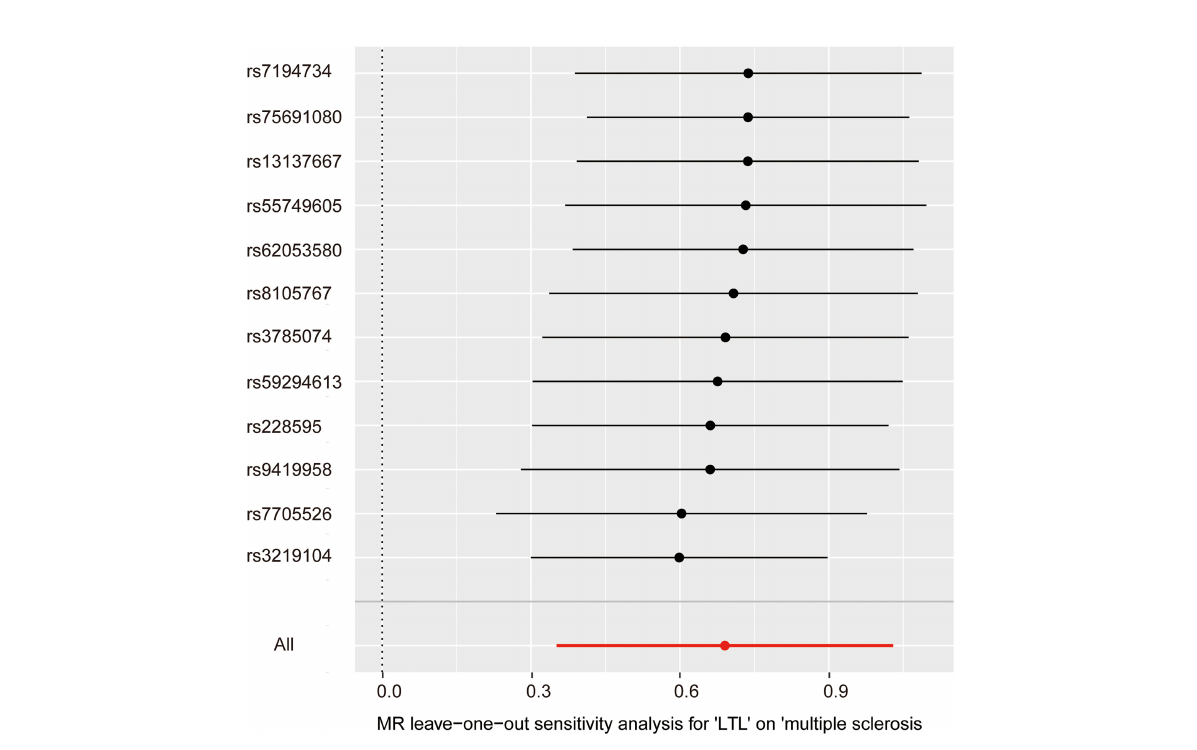
FIGURE 5 Leave-one-out analysis for the impact of individual SNPs on the association between LTL and MS risk. By leaving out exactly one SNP, it shows how each individual SNP in fl uences the overall